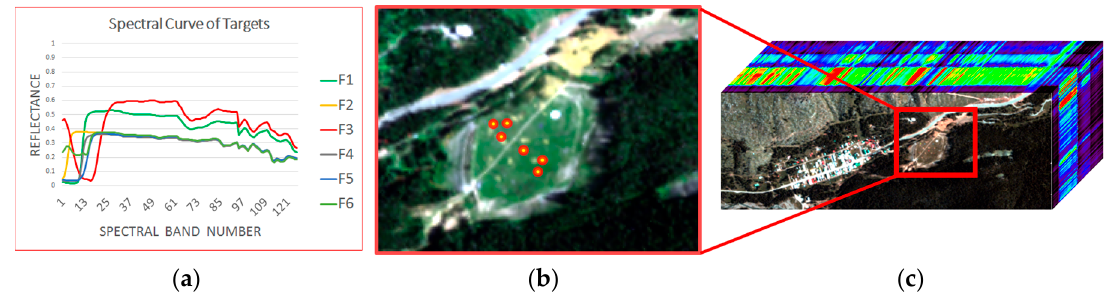
Figure 3. Rochester Institute of Technology (RIT) real dataset: ( a ) the spectral curve of targets; ( b ) the location of targets in selected subset; and, ( c ) original data.